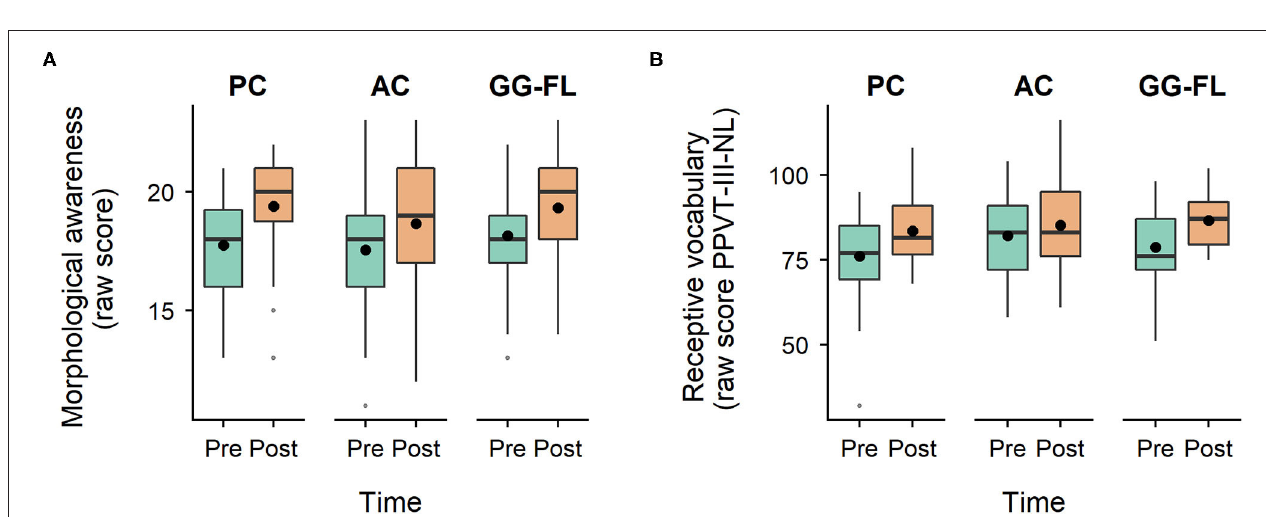
FIGURE 7 | Non-specifically trained broader language skills. (A) , Distribution of morphological awareness scores across groups and timepoints. (B) , Distribution of receptive vocabulary scores across groups and timepoints. PPVT-III-NL, Peabody Picture Vocabulary Task-III-NL; PC, passive control group; AC, active control group; GG-FL, GraphoGame Flemish group. Black dots represent the mean of the raw